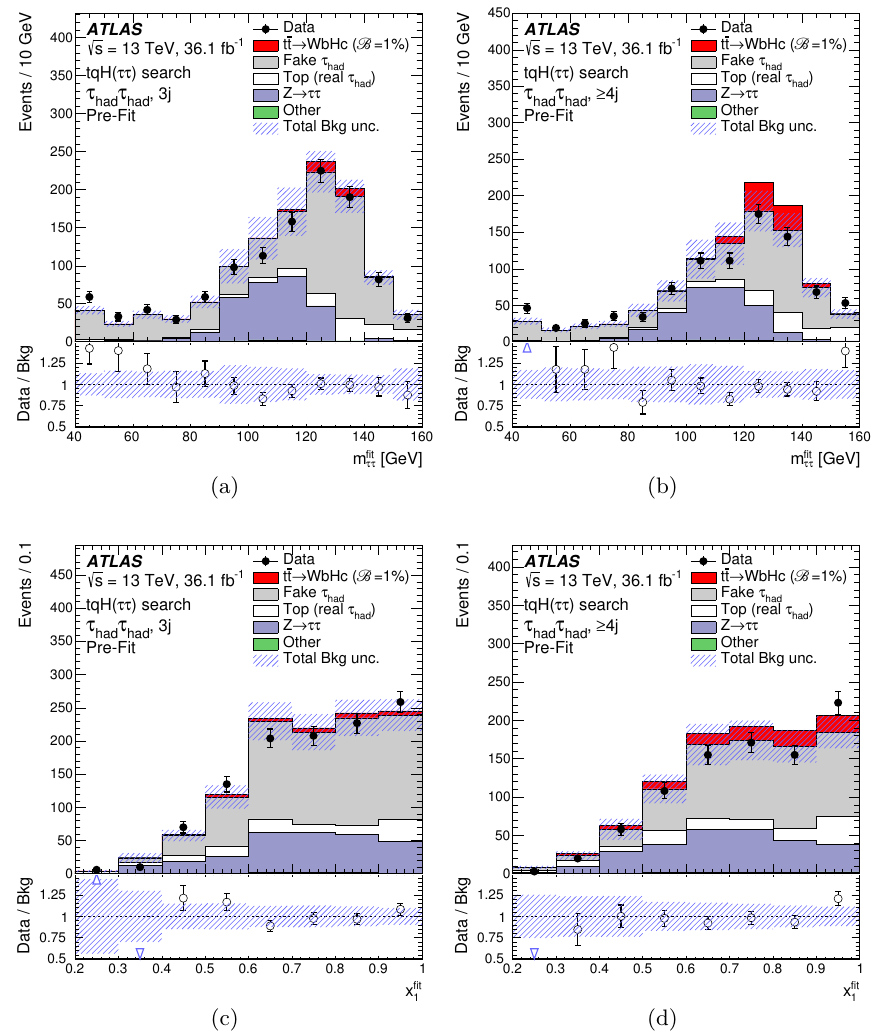
Figure 5 . tqH ( (cid:28)(cid:28) ) search: comparison between the data and predicted background after prese- lection for the distributions of two of the most discriminating BDT input variables in the (cid:28) had (cid:28) had channel before the (cid:12)t to data (\Pre-Fit"). The distributions are shown for m (cid:12)t in (a) the ( (cid:28) had (cid:28) had , (cid:28)(cid:28) 3j) region and (b) the ( (cid:28) had (cid:28) had , (cid:21) 4j) region, and for x (cid:12)t in (c) the ( (cid:28) had (cid:28) had , 3j) region and (d) the 1 ( (cid:28) had (cid:28) had , (cid:21) 4j) region. The contributions with real (cid:28) had candidates from t (cid:22) t , t (cid:22) tV , t (cid:22) tH , and single-top- quark backgrounds are combined into a single background source referred to as \Top (real (cid:28) had )", whereas the small contributions from Z ! ‘ + ‘ (cid:0) ( ‘ = e; (cid:22) ) and diboson backgrounds are combined into \Other". The expected t (cid:22) t ! WbHc signal (solid red) corresponding to B ( t ! Hc ) = 1% is also shown, added to the background prediction. The (cid:12)rst and the last bins in the (cid:12)gures in (a) and (b) contain the under(cid:13)ow and over(cid:13)ow respectively. The bottom panel displays the ratio of data to the SM background (\Bkg") prediction. The hashed area represents the total uncertainty of the background, excluding the normalisation uncertainty of the fake (cid:28) had background, which is determined via a likelihood (cid:12)t to data.